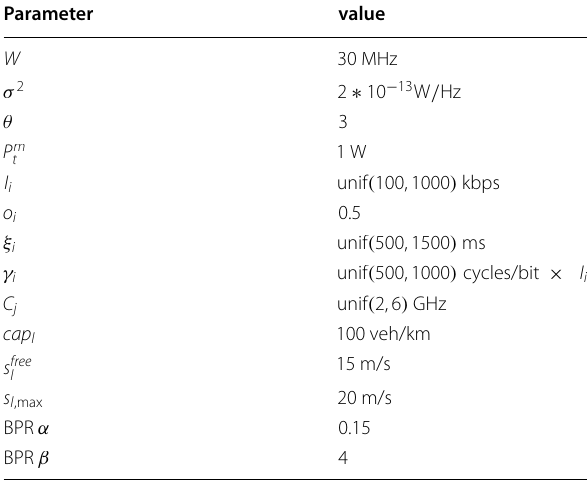
Table 1 Detailed parameters of experiment Parameter